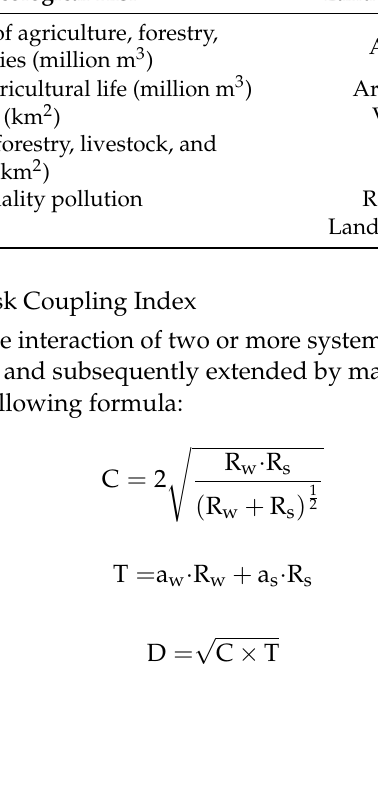
Table 1. Input-output indicators for agroecological risks of WLR use. Water Resources Ecological